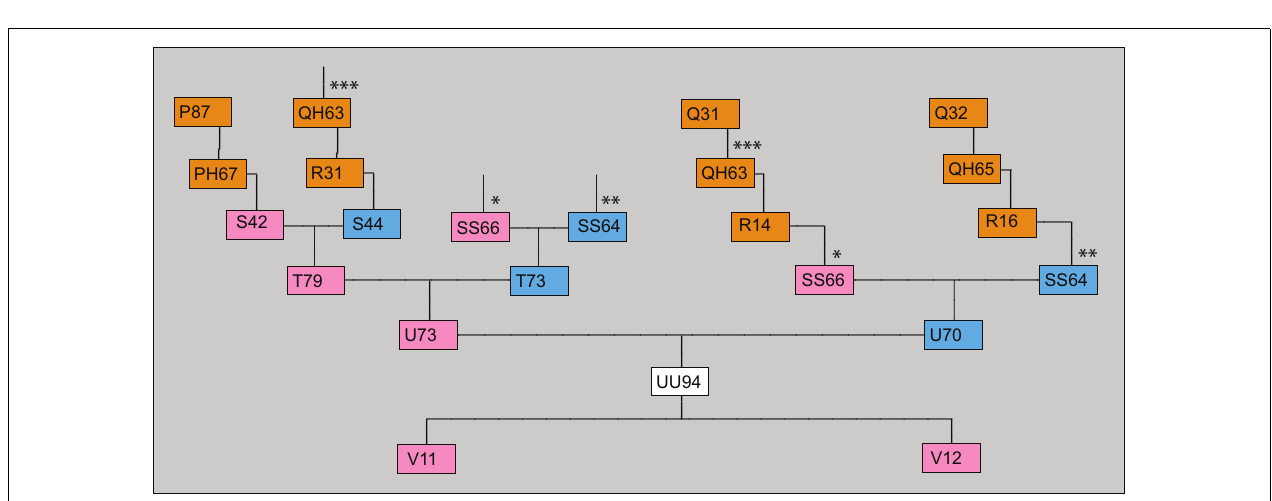
FIGURE 4 | Family tree containing duplicate record markings. Family tree for individual UU94 showing duplicate marking “*” on individual SS66 because it is used both as the paternal grandmother and a maternal great-grandmother. Parental information for SS66 is therefore only showed